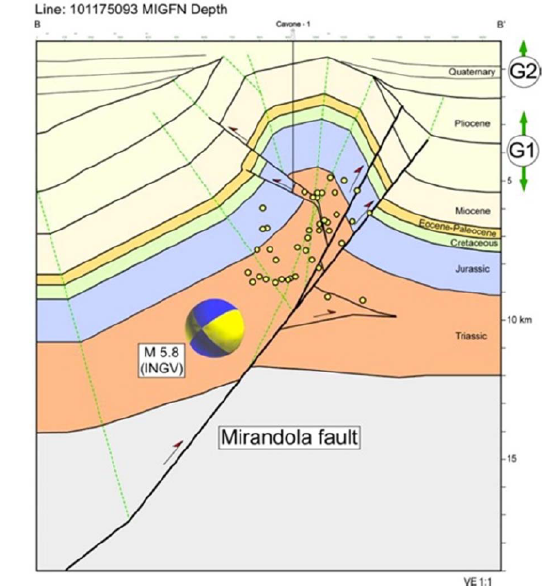
Figure 1. Location and geometry of Mirandola fault with 2012 earthquakes location reproduced from the Cavone Report [7]: Geologic section showing location and focal mechanism of the May 29th